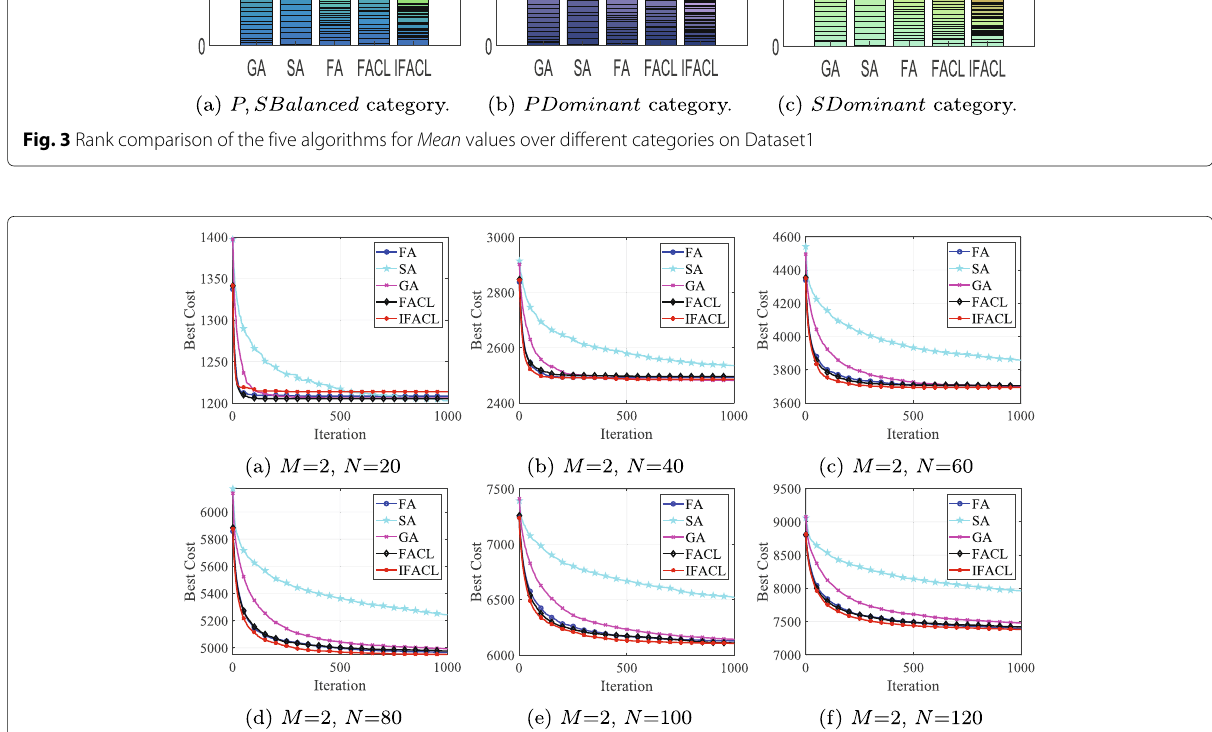
Fig. 4 Average convergence curve for each algorithm on P , SBalanced instances of Dataset1 when the number of machines M =2